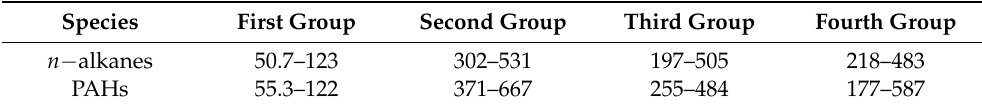
Table 2. The recoveries of 17 n − alkanes and 11 PAHs by ASE pretreatment under the different experimental parameters